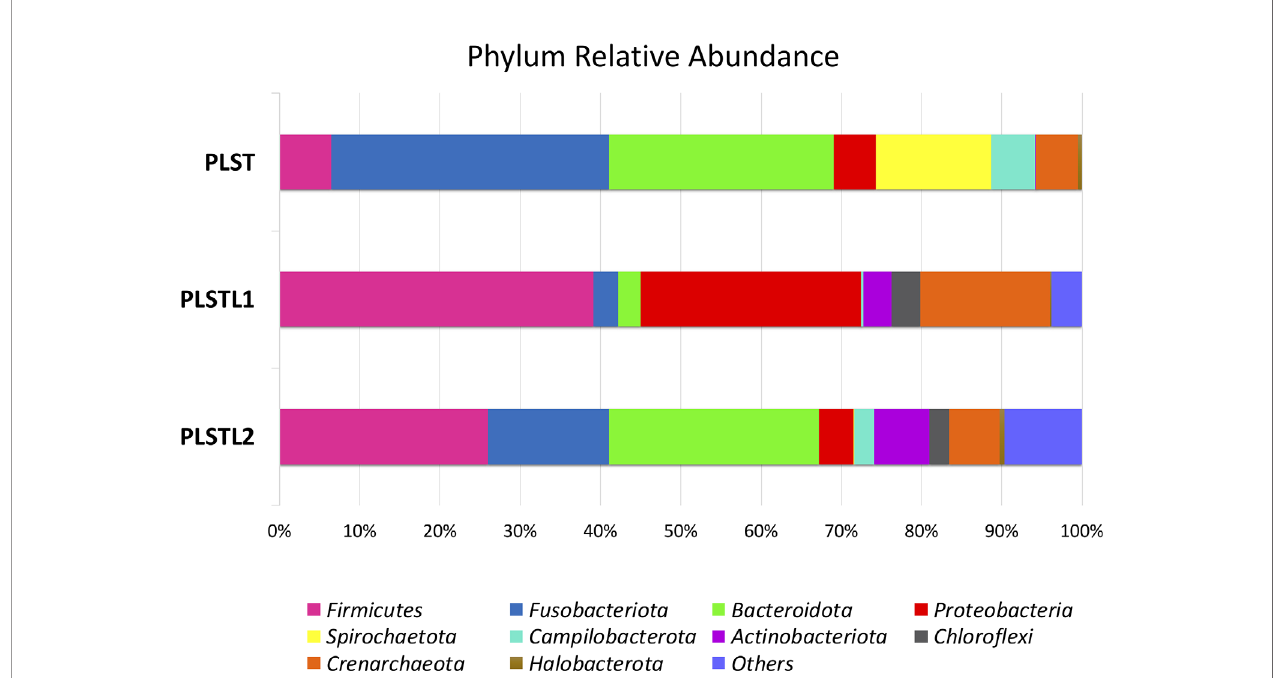
FIGURE 3 | Distribution of phyla in the salivary microbiome of the sisters with Papillon – Lefèvre syndrome. Papillon – Lefèvre syndrome toothed (PLST), Papillon – Lefèvre syndrome toothless 1 (PLSTL1), and Papillon – Lefèvre syndrome toothless 2